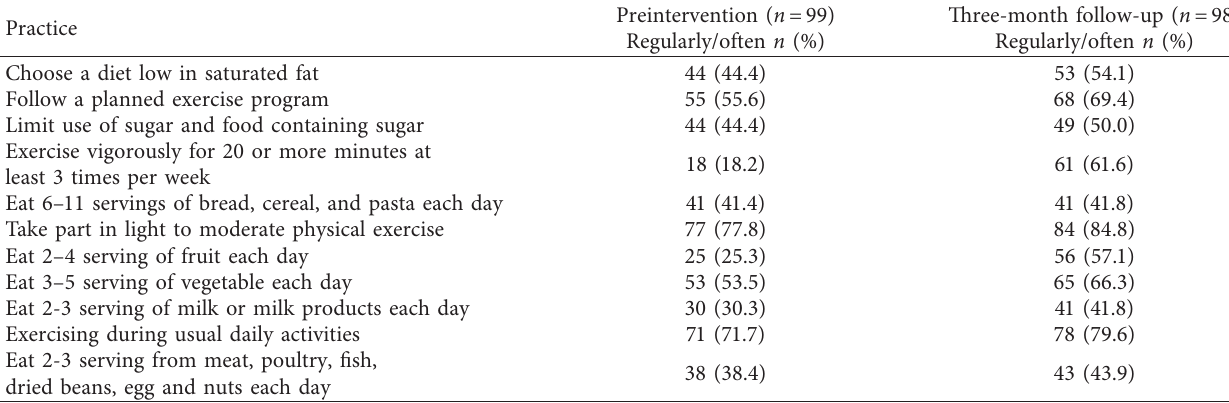
Table 2: Percentage distribution of women who regularly/often practice healthy nutrition and physical activity at preintervention and postintervention.